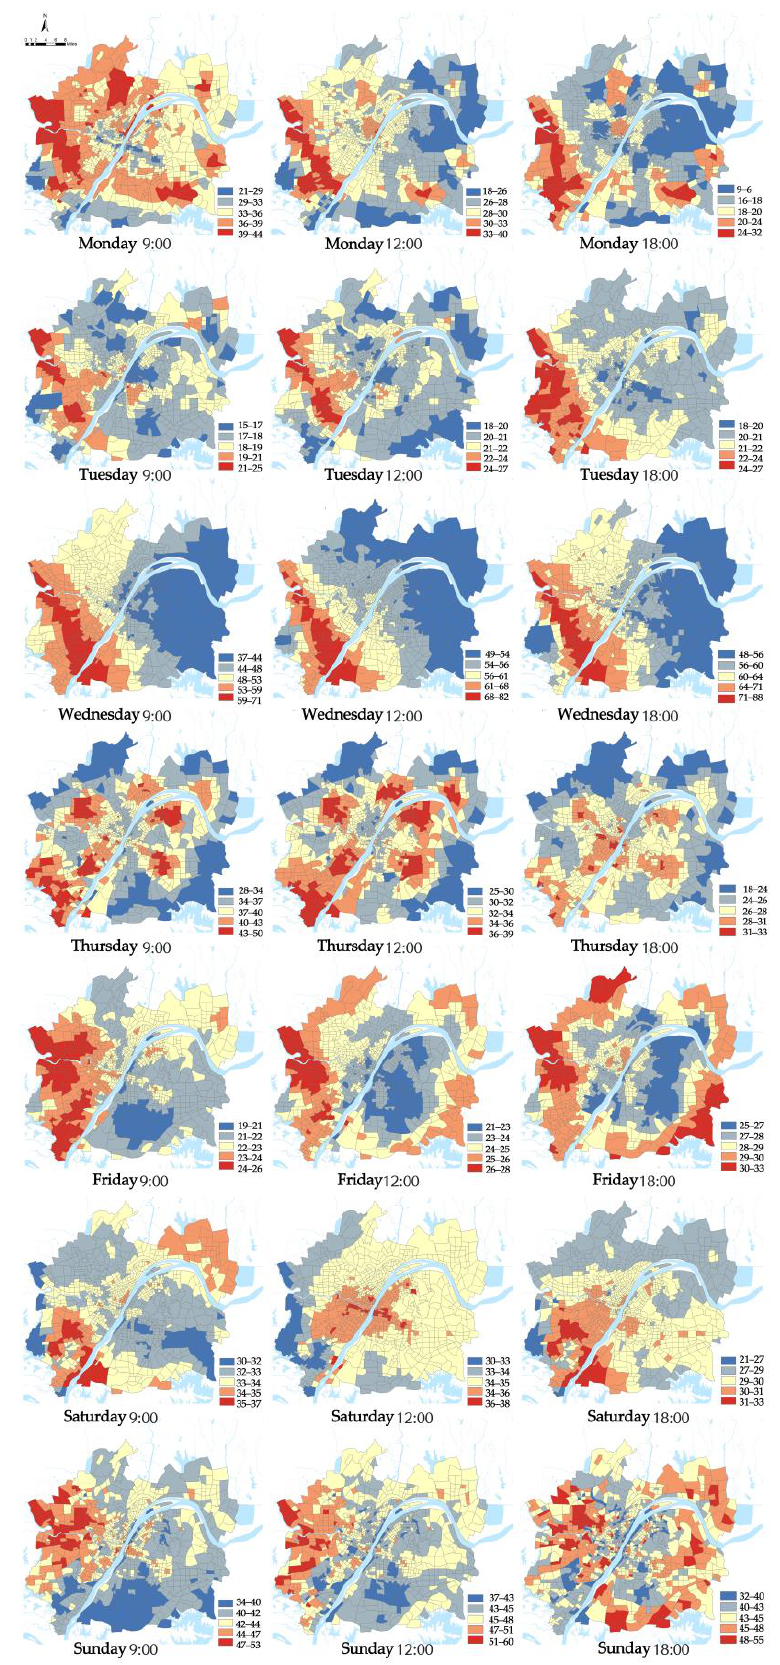
Figure 3. Spatial distribution of hourly PM 2.5 concentrations in the urban blocks of Wu- han .